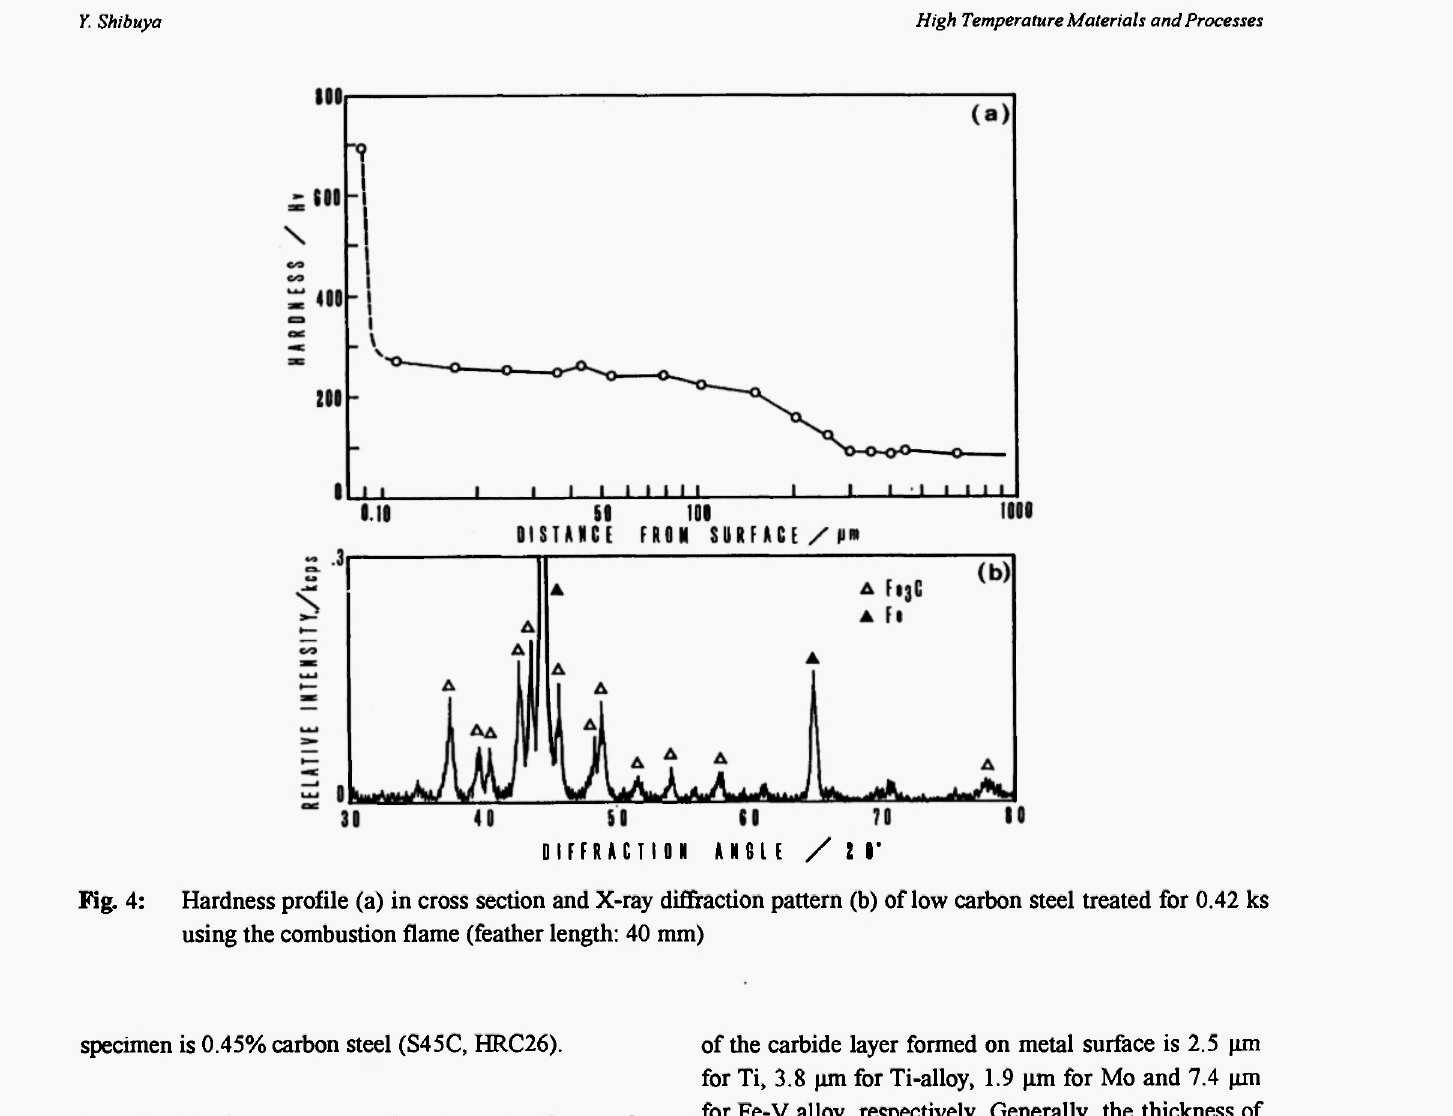
specimen is 0.45% carbon steel (S45C,